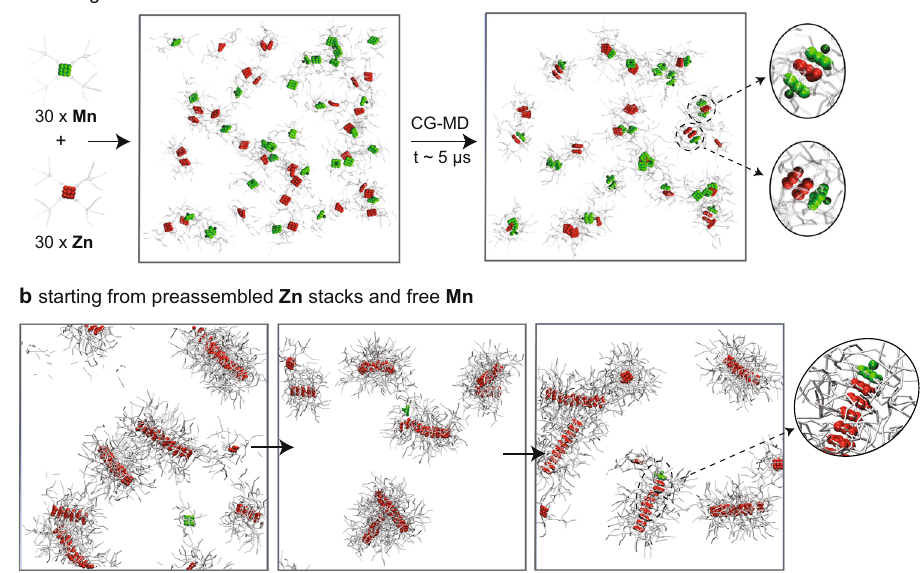
Fig. 5 CG simulations of co-assembly of Mn and Zn monomers. Simulations starting from ( a ) free monomers or ( b ) preassembled Zn stacks and free Mn . All the simulations performed described above were carried out using GROMACS 60 version 2018.6, patched with the PLUMED version 2.5.0 61,62